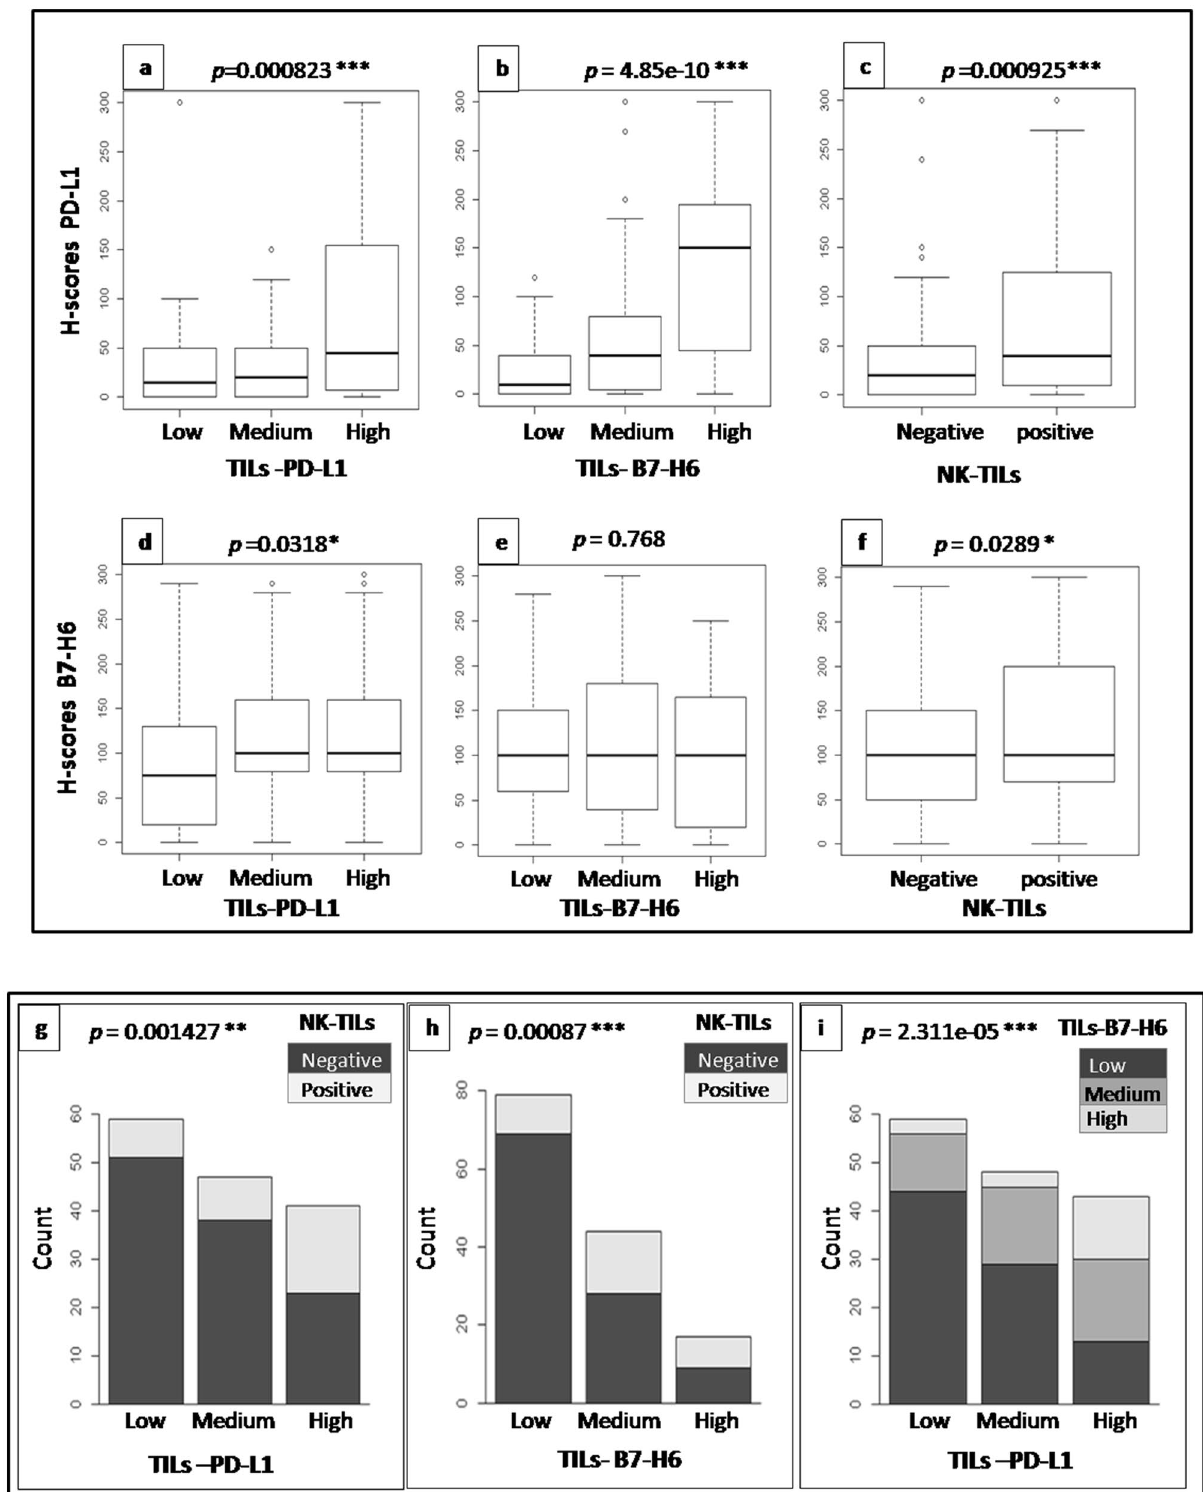
Figure 2. B7-H6 and PD-L1 expressions features associations with TILs-PD-L1, TILs-B7-H6 and NK-TILs status. TILs-B7-H6 and TILs-PD-L1 were evaluated using the three-tier scoring system from high-power field (HPF) areas: 0–5%/HPF (Low), 5–50%/HPF (Medium), > 50%/HPF (High). Boxplot representations of H-score PD-L1 distribution according to TILs-PD-L1 status ( a , p < 0.001), TILs-B7-H6 status ( b , p < 0.001) and NK-TILs status ( c , p < 0.001). Boxplot representations of H-score B7-H6 distribution according to TILs-PD-L1 status ( d , p < 0.05), TILs-B7-H6 status ( e , p = 0.768) and NK-TILs status ( f , p < 0.05). Barplot representations showing NK-TILs distribution according to TILs-PD-L1 status ( g , p < 0.01) and TILs-B7-H6 status ( h , p < 0.001). Barplot representation of TILs-B7-H6 distribution among TILs-PD-L1 status ( I , p <